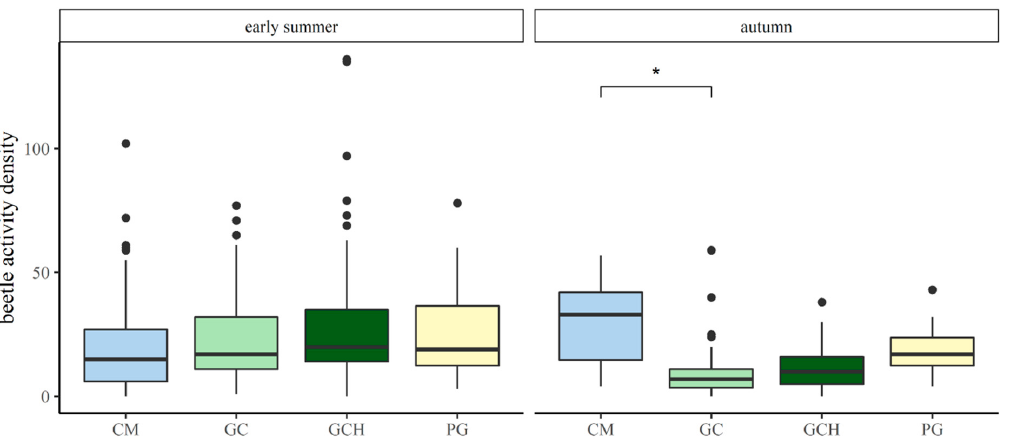
Table 2. Results of the multi-response permutation procedure (MRPP) for carabid assemblages in